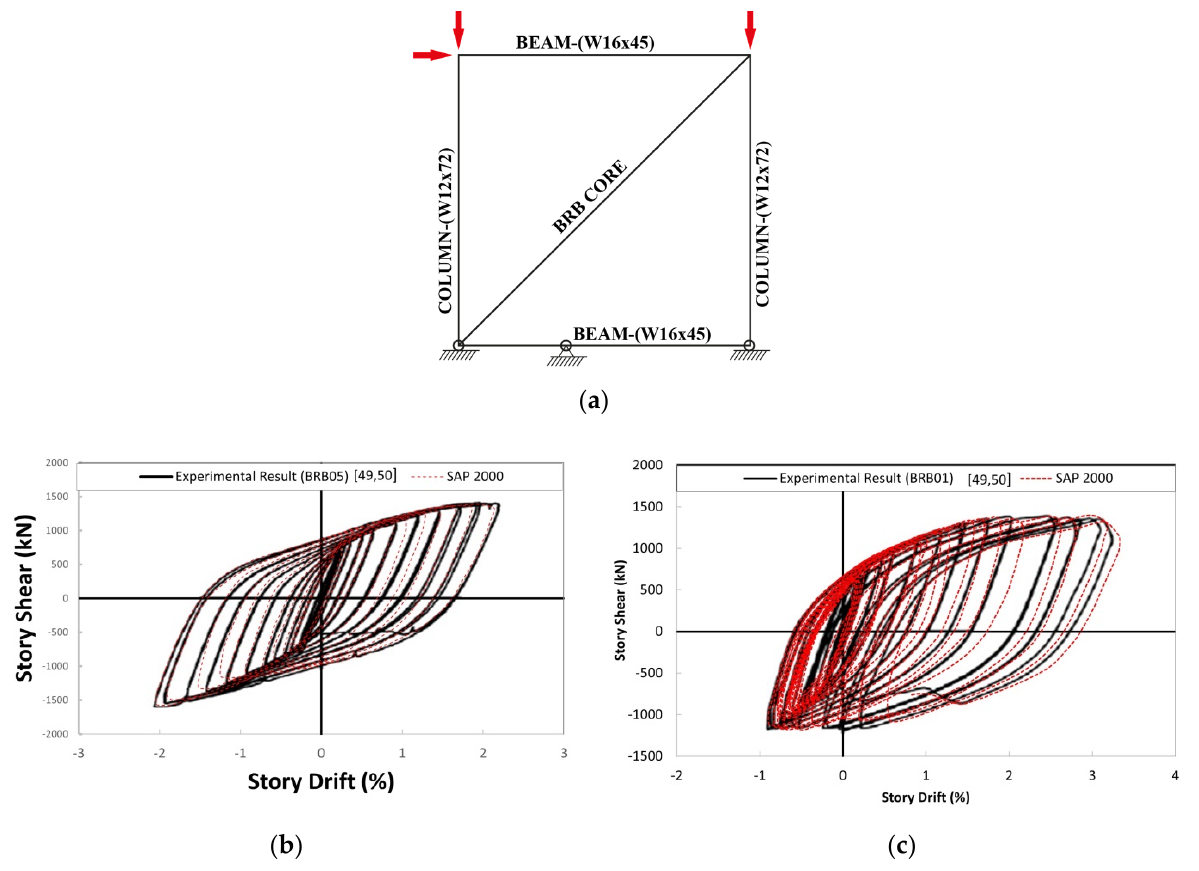
Figure 5. ( a ) Geometry of the BRB-testing frame (Adapted with permission from [49,50]) and verification of SAP 2000 model against the experimental results of BRB ( b ) BRB05 and ( c ) BRB01.